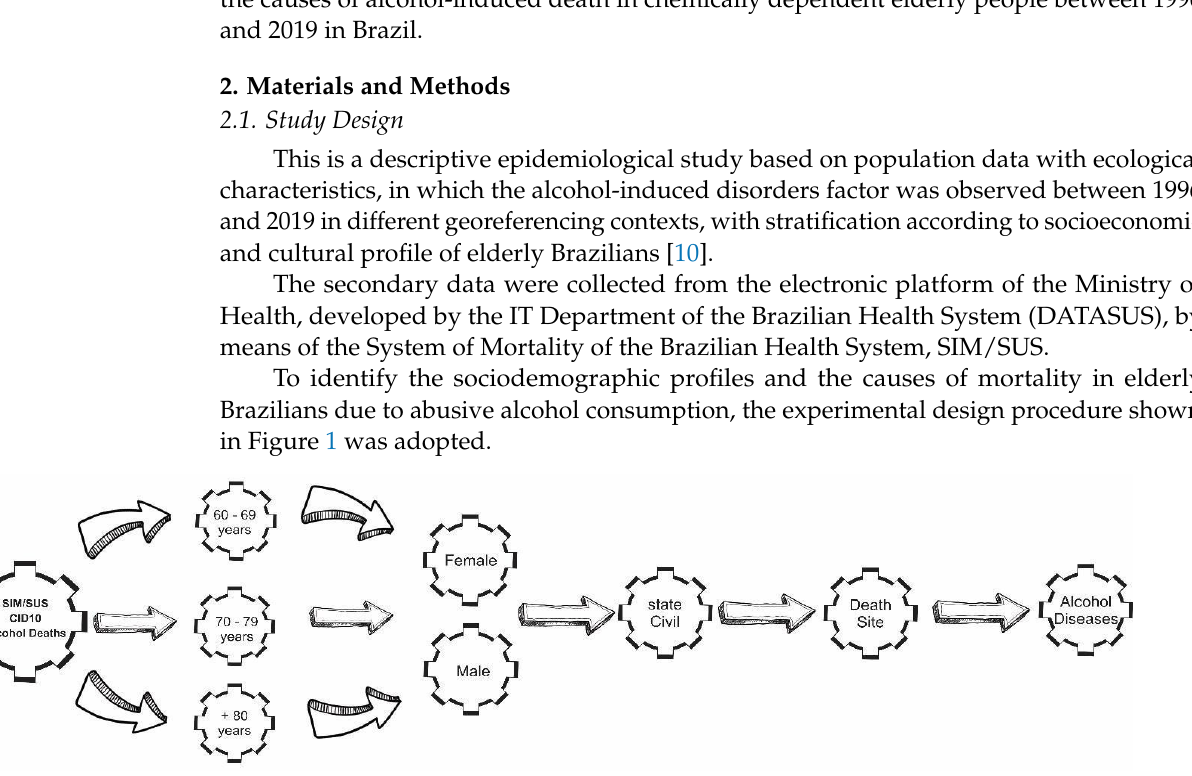
Figure 1. Flowchart of the data collected in SIM/SUS.